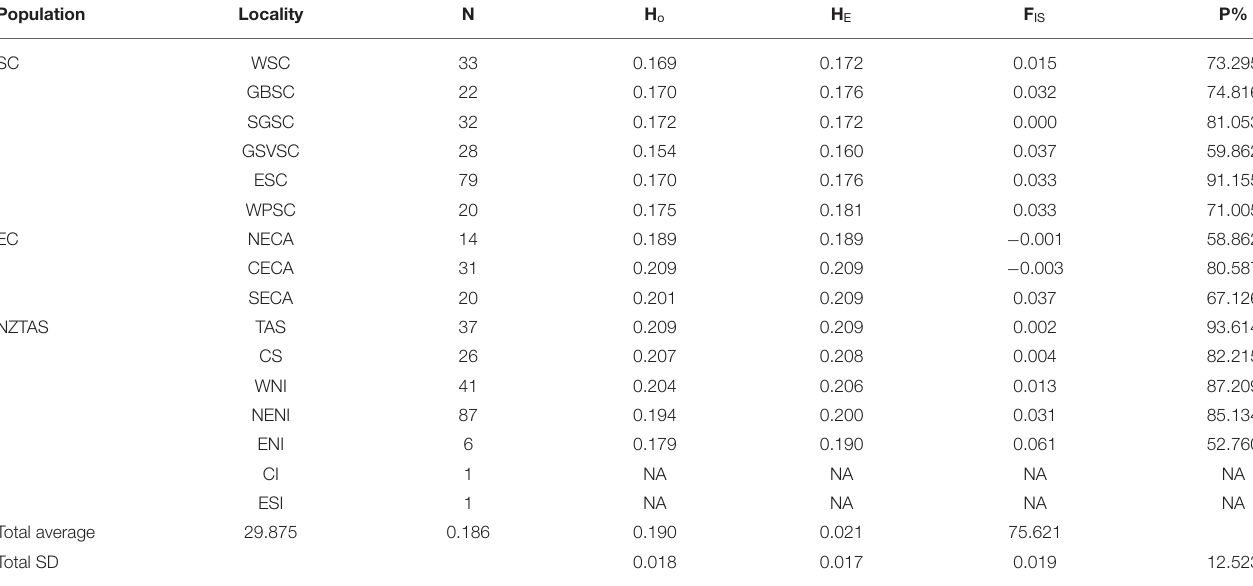
TABLE 1 | Measures of genomic diversity based on 14,799 SNPs for Australasian common dolphins ( Delphinus delphis ) by locality * .